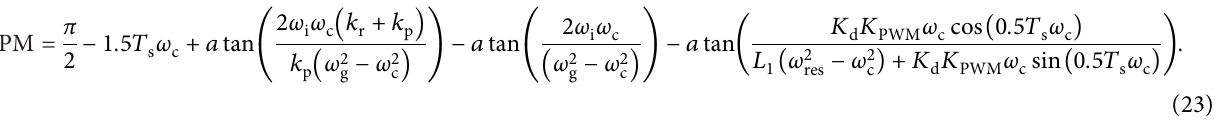
� 25, k � 1500, f � 1 . 65 kHz, and f and k d p r res